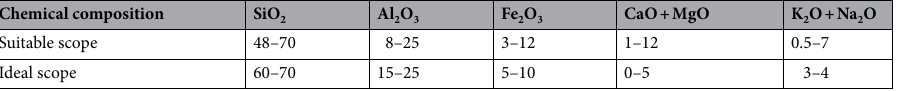
Chemical composition